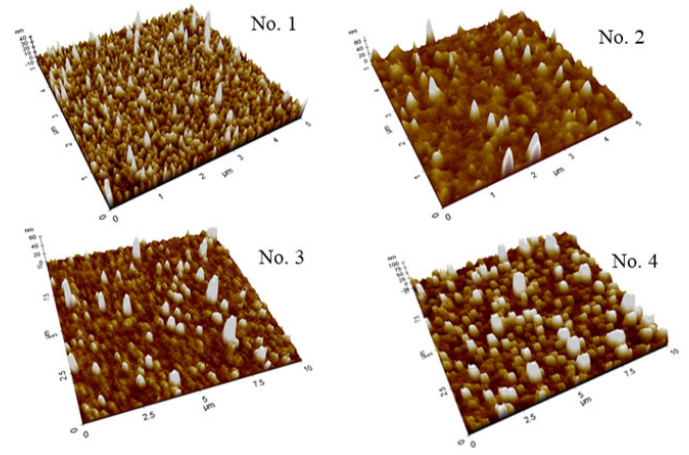
Figure 3. AFM images of the prepared catalytic electrode surface by plasma deposition (see Table 1).